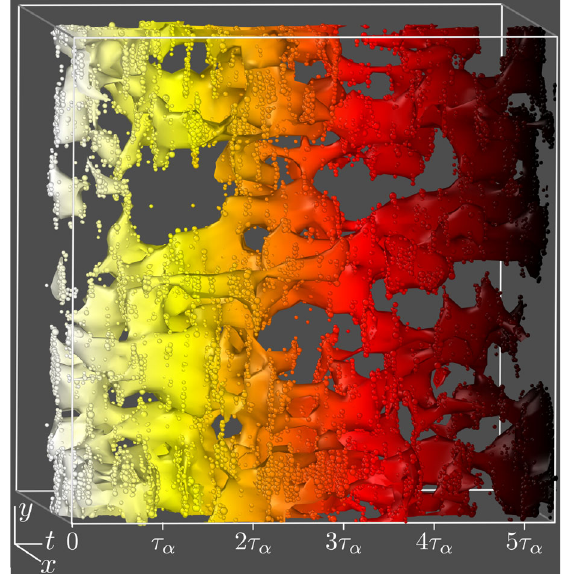
FIG. 16. Space-time trajectory in the 2D model. A trajectory 8 × 10 8 (right) at T ¼ starting at t ¼ 0 (left) finishing at t max ¼ 0 . 09 is split into 400 time slices of duration Δ t ¼ 2 × 10 6 . We show all particles that are mobile within a given time slice, together with a surface representation which draws a contour of the coarse-grained mobility field. To ease d þ 1 visualization, the color linearly codes for the time dimension, and one half of the system in the x direction is removed.